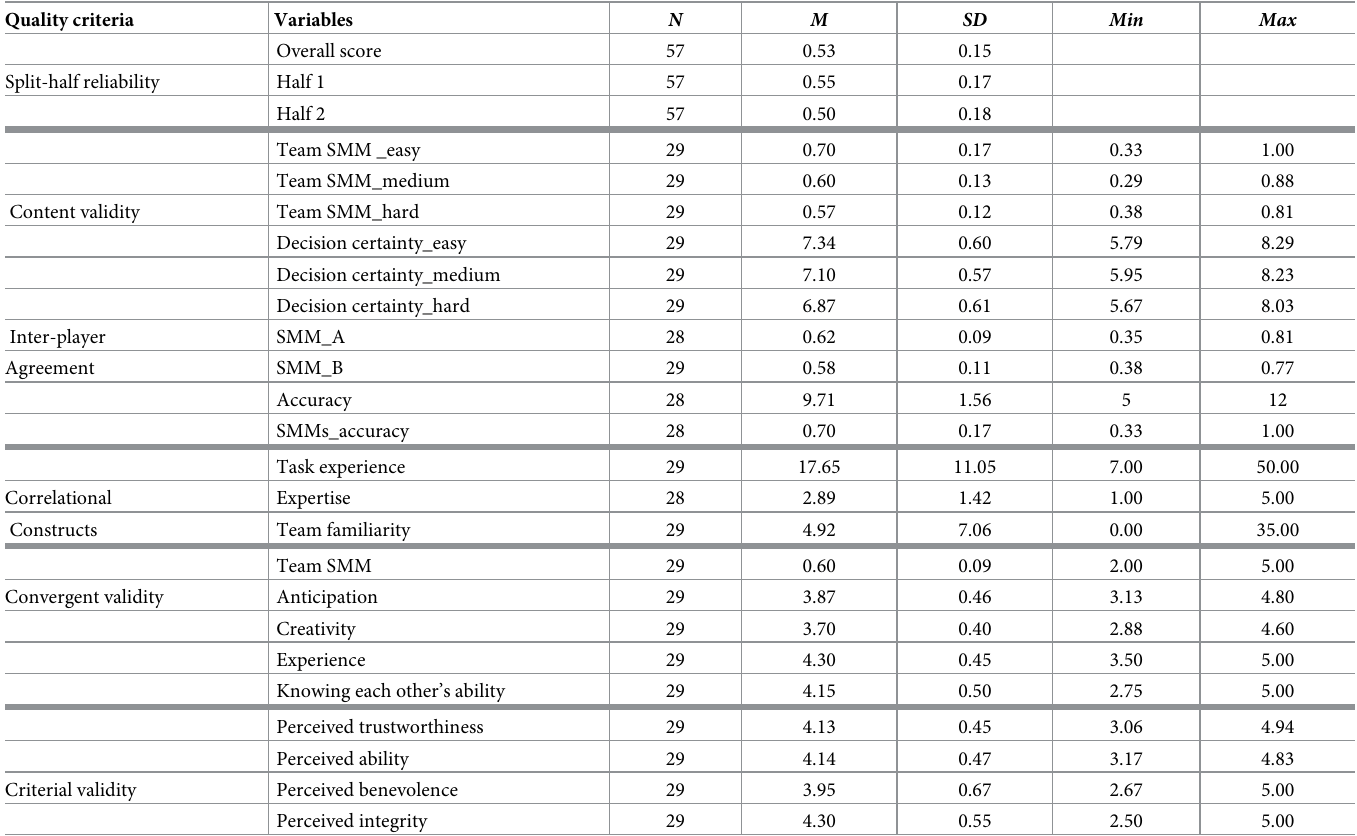
Table 3. Descriptives in the main